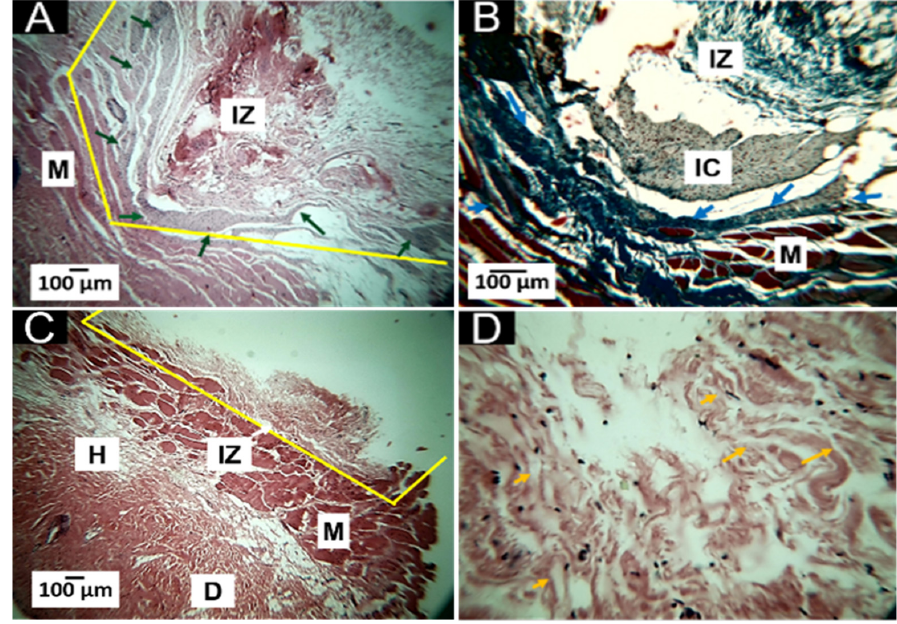
Figure 9. Subdermal implant formulation T3, 50%G:50%CS. ( A ): Implantation at 30 days, the image at 4 × , H&E technique. ( B ): Implantation at 30 days, the image at 10 × , MT technique. ( C ): Implantation at 60 days, 4 × image, H&E technique. ( D ): Implantation at 60 days, the image at 40 × , H&E technique. M: muscle. IZ: implantation zone. IC: inflammatory cells. Yellow arrow: fragments of the biomaterial. Blue arrows: connective tissue (type I collagen).